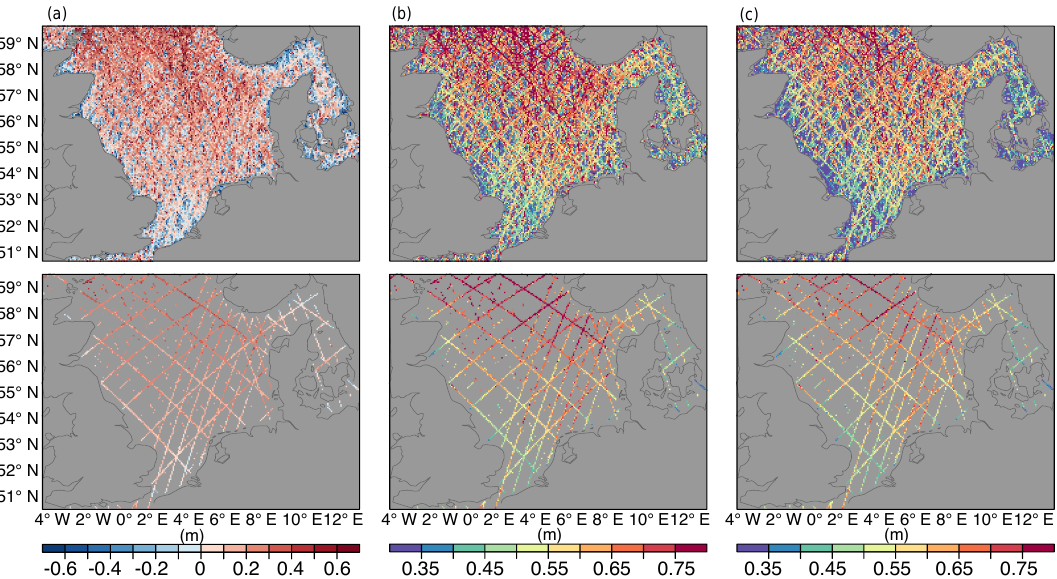
Figure 5. Spatial distribution of bias (a) , root mean square error (b) and standard deviation of the error (c) [m] between SWHs from the coastDat2 hindcast and the GlobWave data set for the period 1992–2014 when all available satellite data are used for comparison (top) and when only data with more than 100 flyovers per grid point are used (bottom).